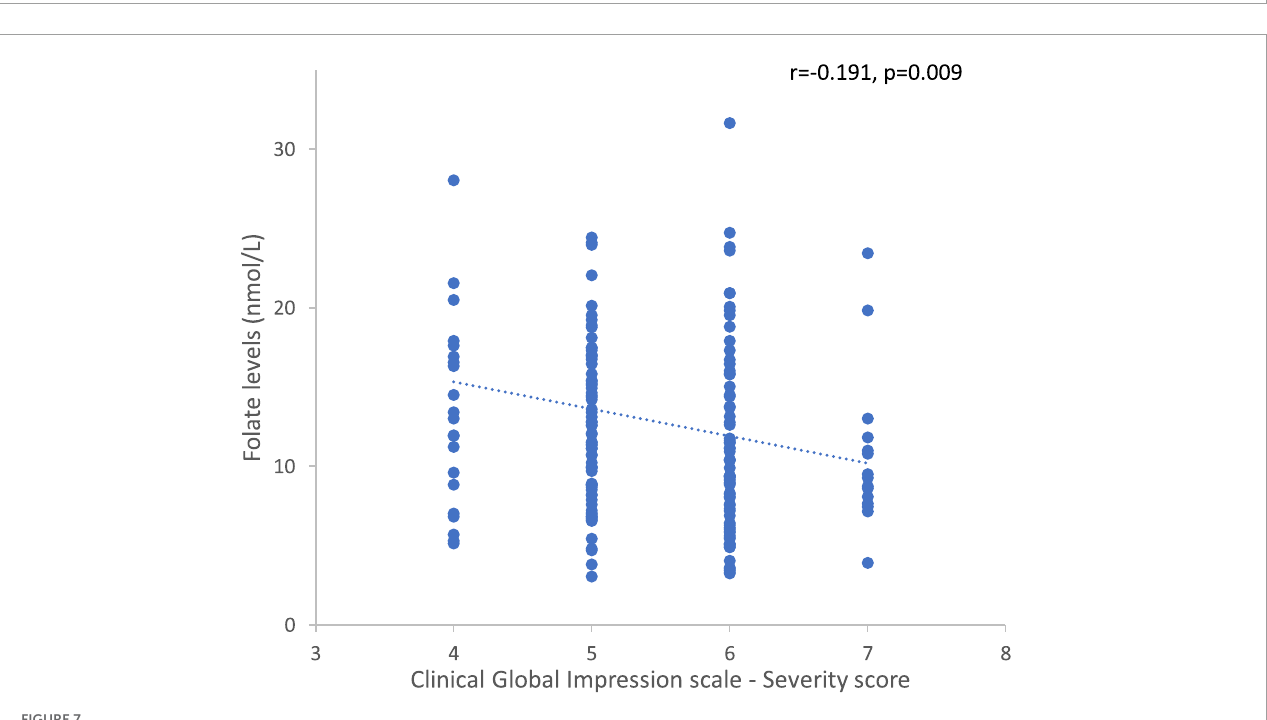
FIGURE6 Correlation between homocysteine levels and age in the whole sample.